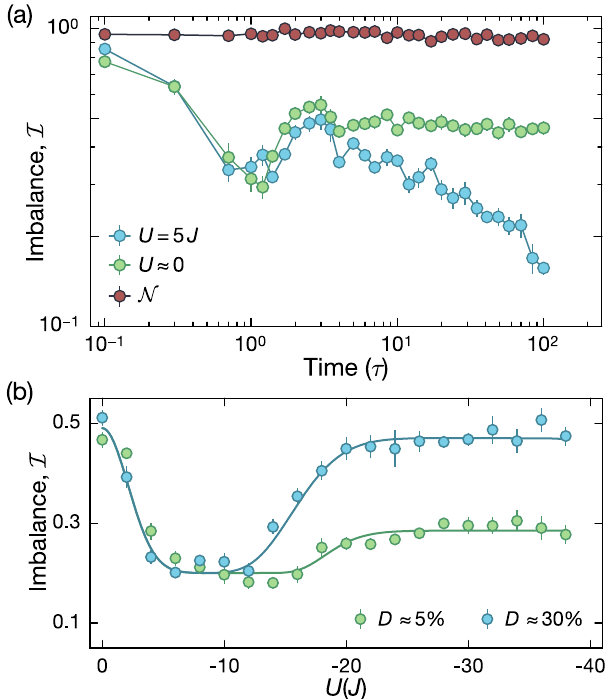
FIG. 4. Interaction and energy density dependence. (a) Time evolution of the imbalance for fixed disorder strength Δ ¼ 5 J and vanishing U ≈ 0 and finite interactions U ¼ 5 J . While there is negligible relaxation in the noninteracting case, the interacting time trace shows slow relaxation. This indicates that the relax- ation is inherently due to interactions. We also show the normalized total atom number N to show that atom loss is minimal on the time scales of the experiment [40]. (b) We measure the imbalance for fixed disorder strength Δ ¼ 6 J but starting from initial states with two different doublon fractions D ≈ 5% , 30%. In the large interaction limit, we observe a significantly higher imbalance for the larger doublon fraction. This can be qualitatively understood by the reduced mobility of a bound doublon. Each point is averaged over six individual experimental realizations, and error bars denote the error of the mean. Solid lines are guides to the